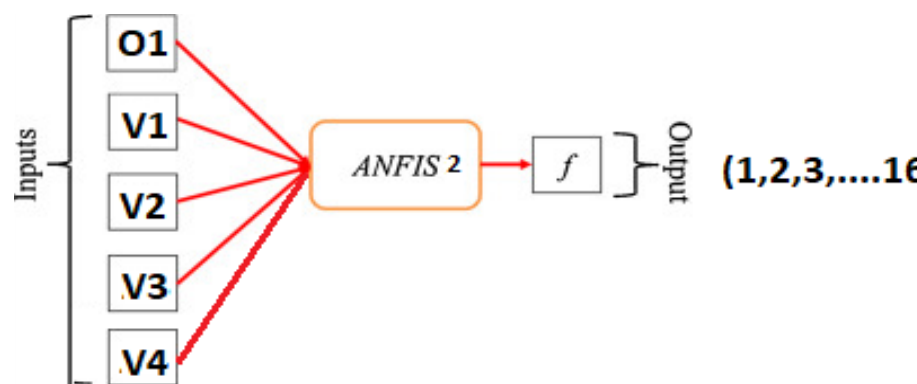
Figure 5. Block diagram of ANFIS Controller 2.